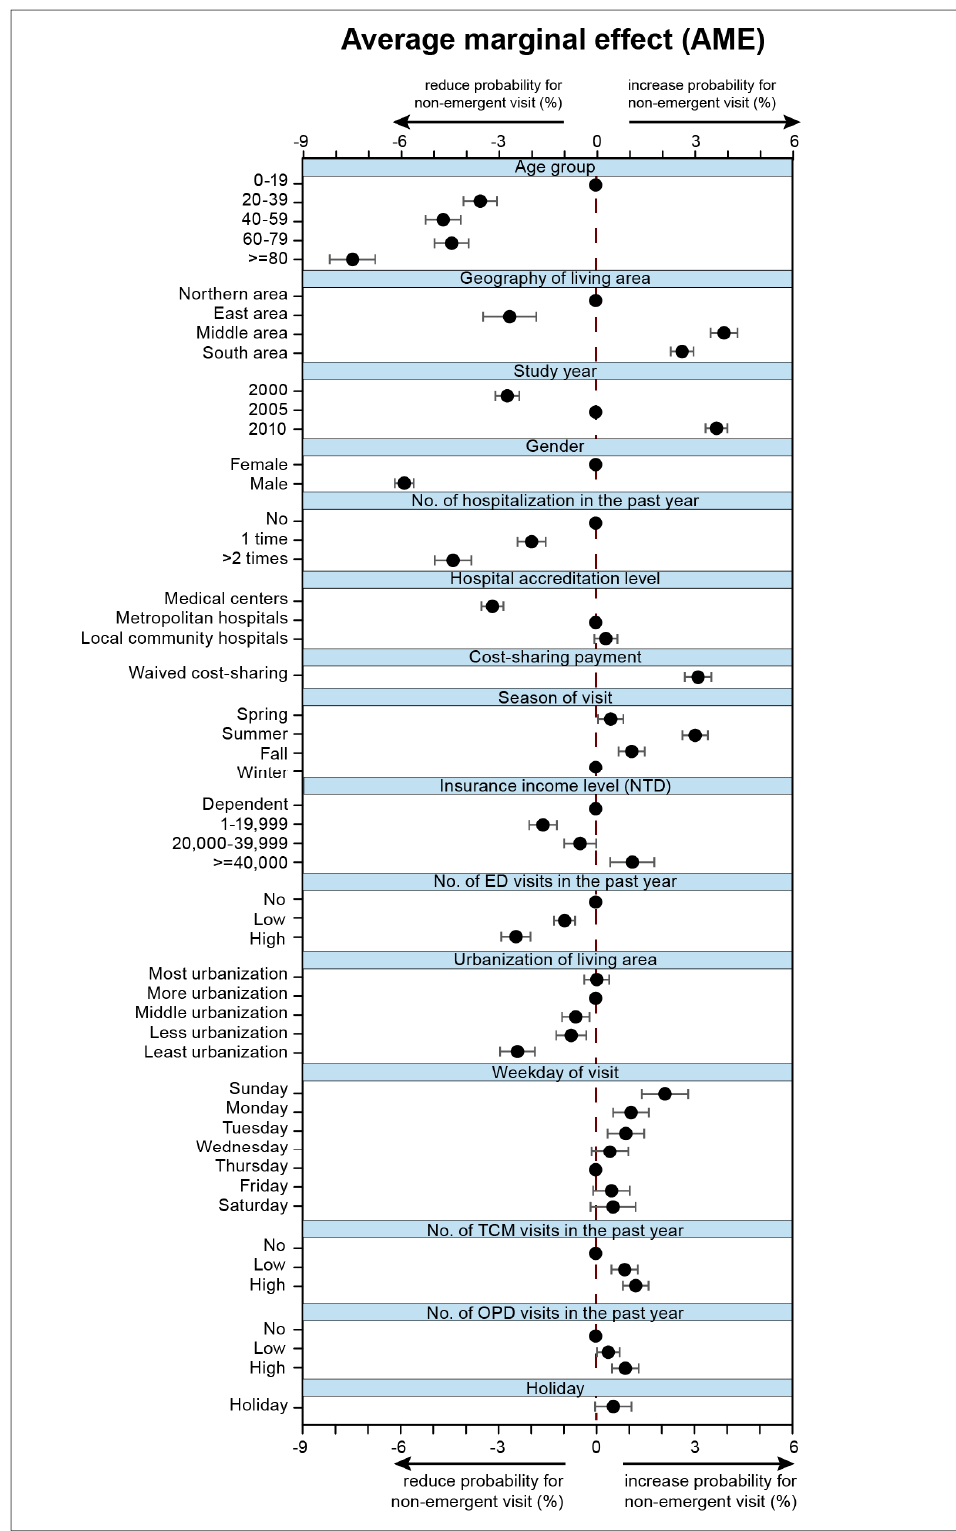
Figure 2. Average marginal effects (AME) of factors for non-emergent ED visits ordered by effect size from three representative study cohorts (LHID2000, LHID2005, LHID2010) in Taiwan. ( n = 1,000,000 for each cohort, total ED visits, n = 475,862). AME were calculated using a logistic model adjusted for listed factors, in addition to Charlson’s index. The most frequent level of each factor was used as the base value (reference line at zero).